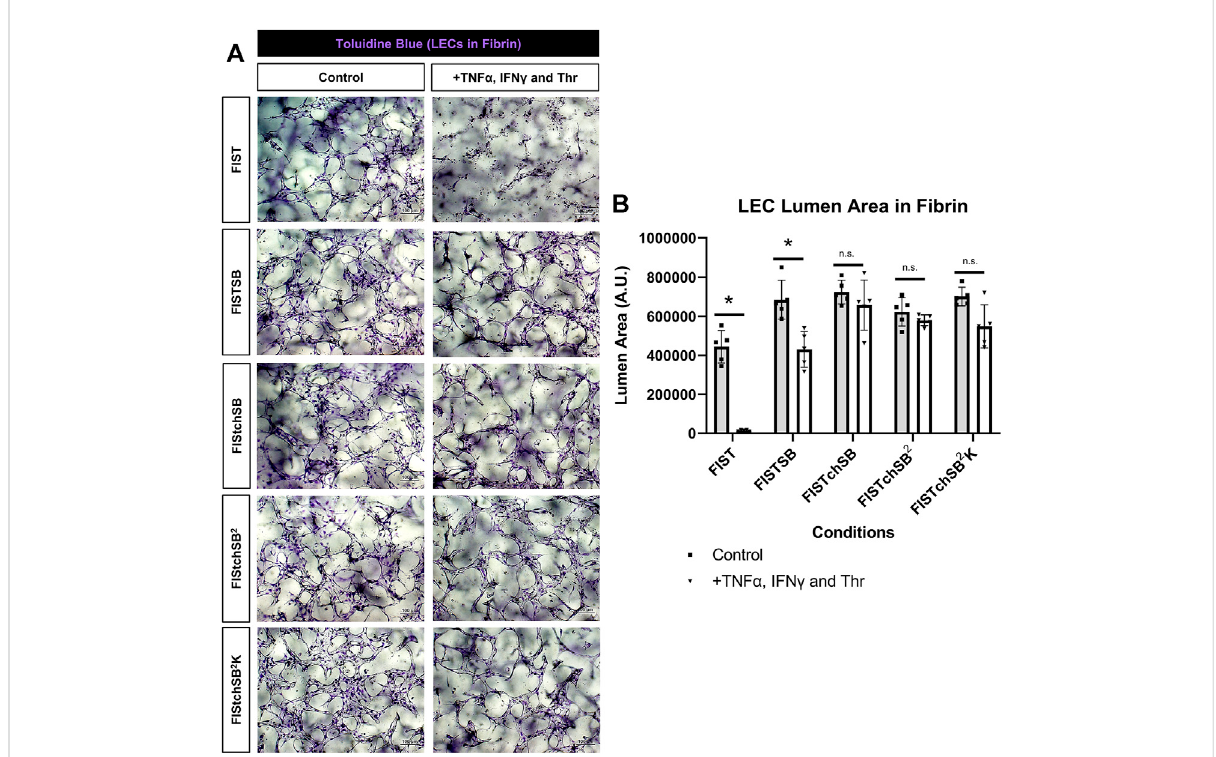
FIGURE 6 Rescuing lymphatic EC tube regression in fi brin matrices induced by TNF (tumor necrosis factor) α , IFN (interferon) γ , and thrombin using combinations of pharmacologic agents. (A,B) Lymphatic endothelial cell (LEC) tube networks were established for 48 h using four-drug pharmacologic combination FIST (10 μ M forskolin, 100 μ M IBMX, 10 μ M SB239063, and 10 μ M Tubacin) in 3-dimensional (3D) fi brin gels. After 48 h, cells were treated with a combination of TNF α 10 ng/ml, IFN γ 10 ng/ml and Thr 1 μ g/ml, with FIST or additional pharmacologic agents: FIST+ 25 μ MSB415286(FISTSB);FIS+10 μ MTCSHDAC620b(tuberoussclerosiscomplexhistonedeacetylase6)+25 μ MSB415286(FISTchSB); FISTchSB +10 μ M SB431542 (FISTchSB 2 ); FISTchSB 2 + 10 μ M K 02288 (FISTchSB 2 K). (A) Fixed cultures were stained with toluidine blue and imaged.